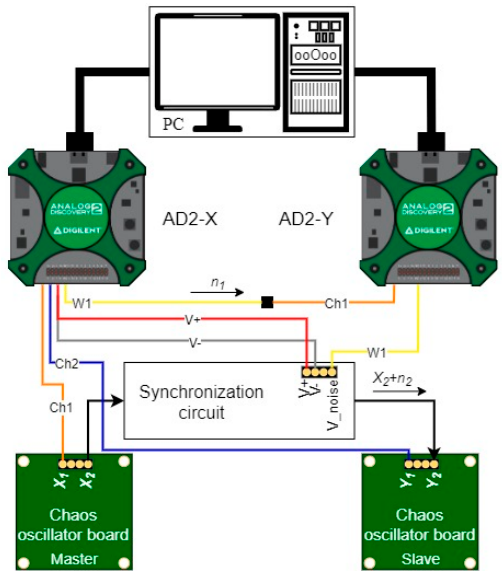
Figure 5. Hardware setup for the experimental study of the noise immunity of the chaos oscillator’s synchronization [17].